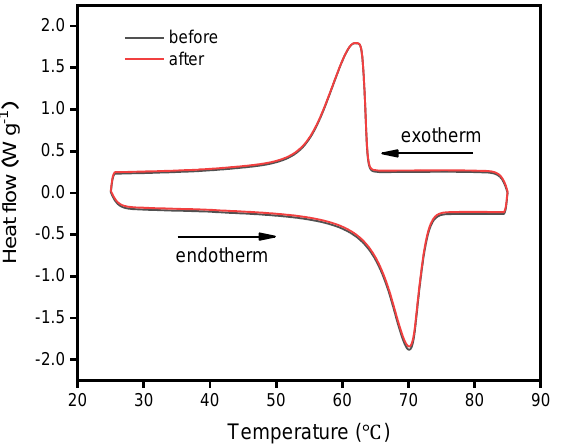
Figure 8. SEM images of CNT-PE-EPDM/EG-based PCM sample C5 before heating-cooling test and after 200 cycles.